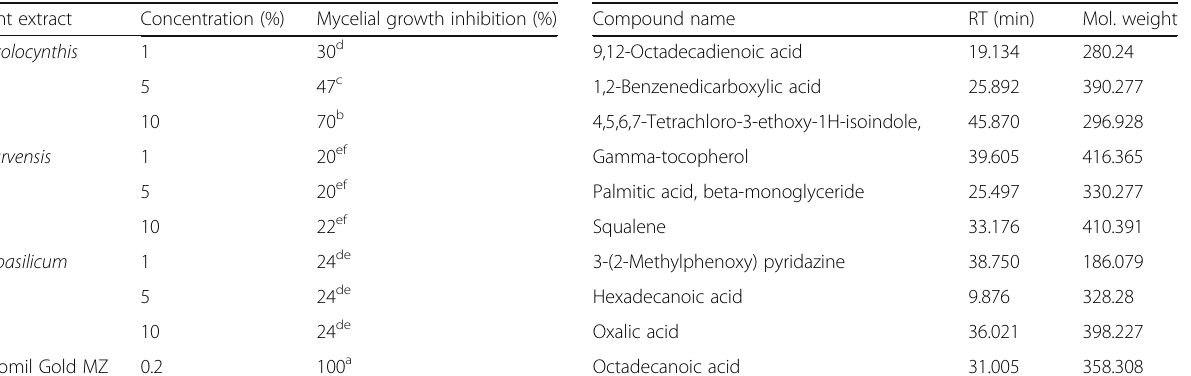
Table 3 Chemical compounds having the total percentage of GC-MS chemical analysis of the aqueous extract of Citrullus